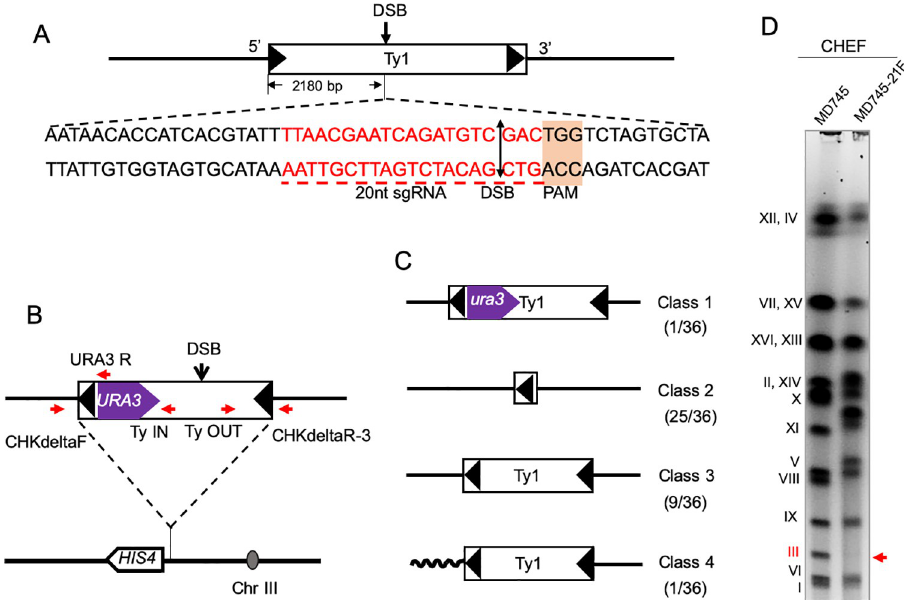
Fig 3. Sequence of CRISPR/Cas9 target in the Ty element, and diagnosis of events causing loss of URA3 insertion from Ty1 :: URA3 . (A) Sequence in Ty1 targeted by the guide RNA (shown in red). (B) Position of marked Ty element on chromosome III, and location of PCR primers used to diagnose 5-FOA-resistant isolates. The distance between the DSB site (CRISPR/Cas9 target) and the 3’ end of URA3 is about 2.5 kb. Large black arrows show the LTRs (delta elements) associated with Ty1. (C) Different classes of 5-FOA-resistant isolates based on PCR analysis. The sizes of the fragments resulting from PCR reactions with various combinations of primers are given in S3 Table. The wavy line in Class 4 indicates a different flanking sequence from the original Ty1 element. (D) CHEF gel analysis of rearranged chromosome III in MD745-21F. The size of chromosome III was altered as a result of a crossover-associated gene conversion. MD745 is the control